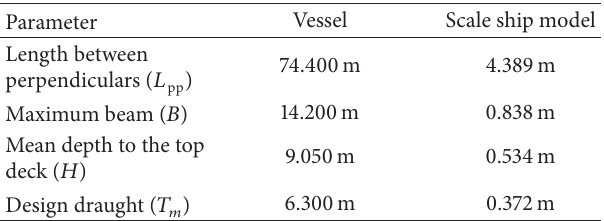
Table 1: Main parameters and dimensions of the vessel and the scale ship model.